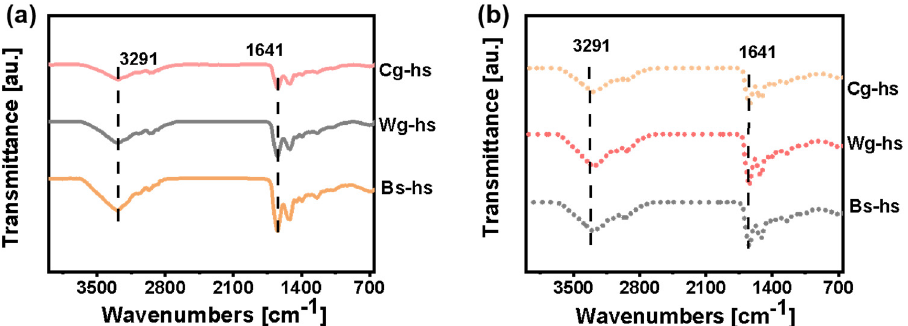
Figure 4. FT ‐ IR curves of different Caprinae horn sheaths: ( a ) dried specimens; ( b ) hydrated specimens. Pink line, grey line and orange line indicates for Cg ‐ hs, Wg ‐ hs and Bs ‐ hs, respectively. Table 2. The secondary structure and main element content in different Caprinae horn sheaths.